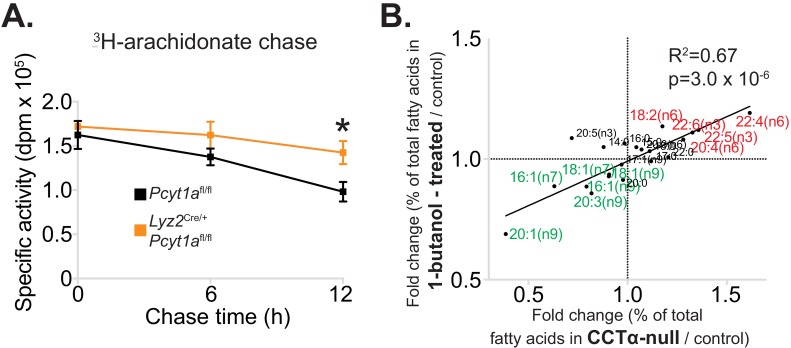
Reduced PC turnover increases membrane PUFA levels in macrophages.(A) 3H-arachidonate levels in Pcyt1afl/fl (n = 4) or Pcyt1afl/fl
Lyz2Cre/+ (n = 4) BMDMs, pulsed with tracer amounts of 3H-arachidonate for 16 hr and chased with medium for indicated periods of time. (B) Linear regression analysis of the correlation between fold changes in the molar fatty acid percentage induced by genetic Pcyt1a deletion (n = 4) and by PLD inhibition using 15 μM 1-butanol for 24 hr (n = 4).